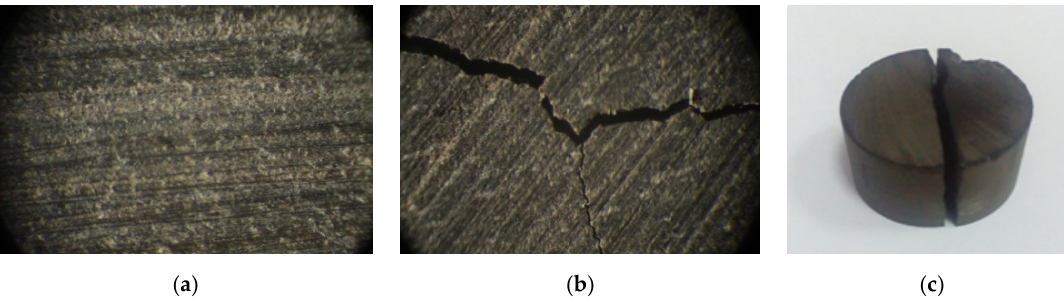
Figure 8. Photos of the microstructure of the Bazhenov Formation sample B5 ( a ) before the treatment; ( b ) after the microwave treatment; and ( c ) after the radio-frequency treatment (48× magnification).